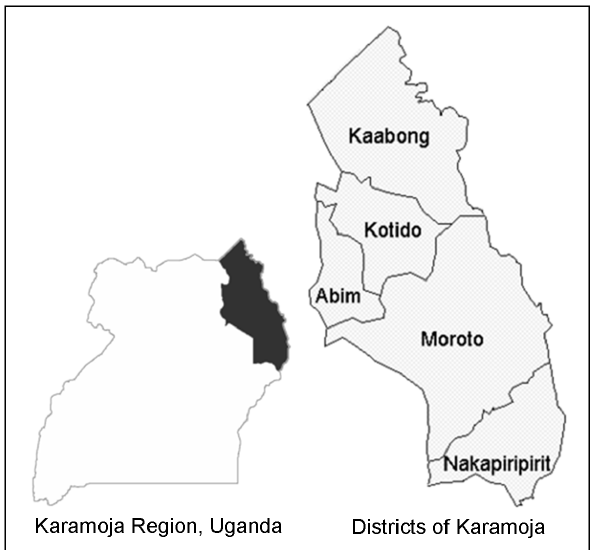
Figure 1. Map of the Karamoja Region and Districts, Uganda.